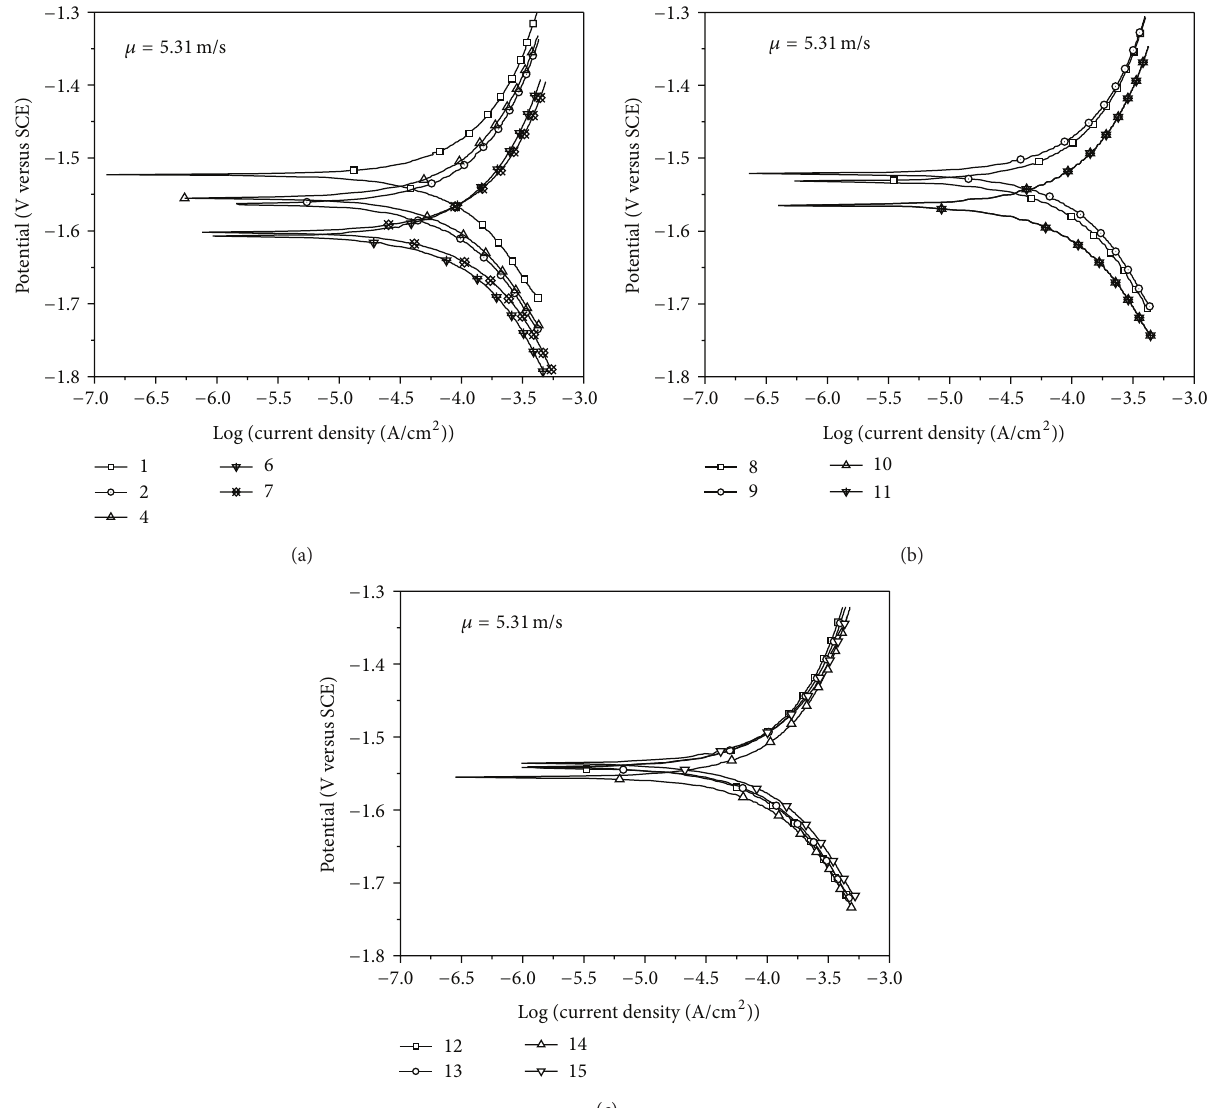
Figure 2: Potentiodynamic polarization curves of array electrodes under fluid flow condition with the flow velocity of 5.31 m/s.